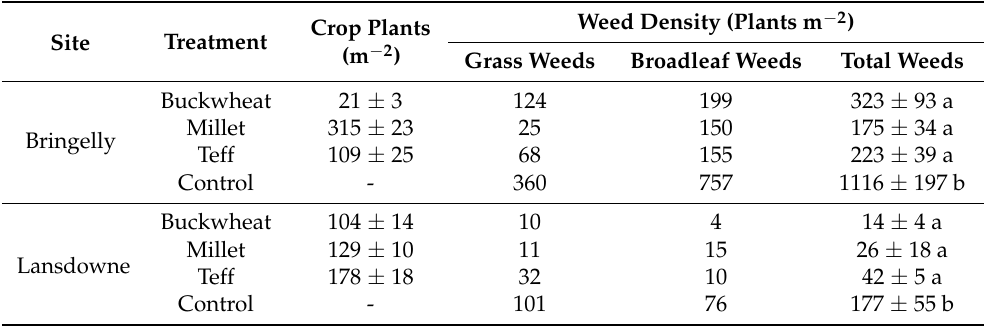
Table 2. Cover crop establishment and weed densities ( ± standard error values) three weeks after crop planting at the Bringelly and Lansdowne trial sites. Different letters show significant differences ( p < 0.05). Weed Density (Plants m − 2 ) Crop Plants Site Treatment (m − 2 ) Grass Weeds Broadleaf Weeds Total